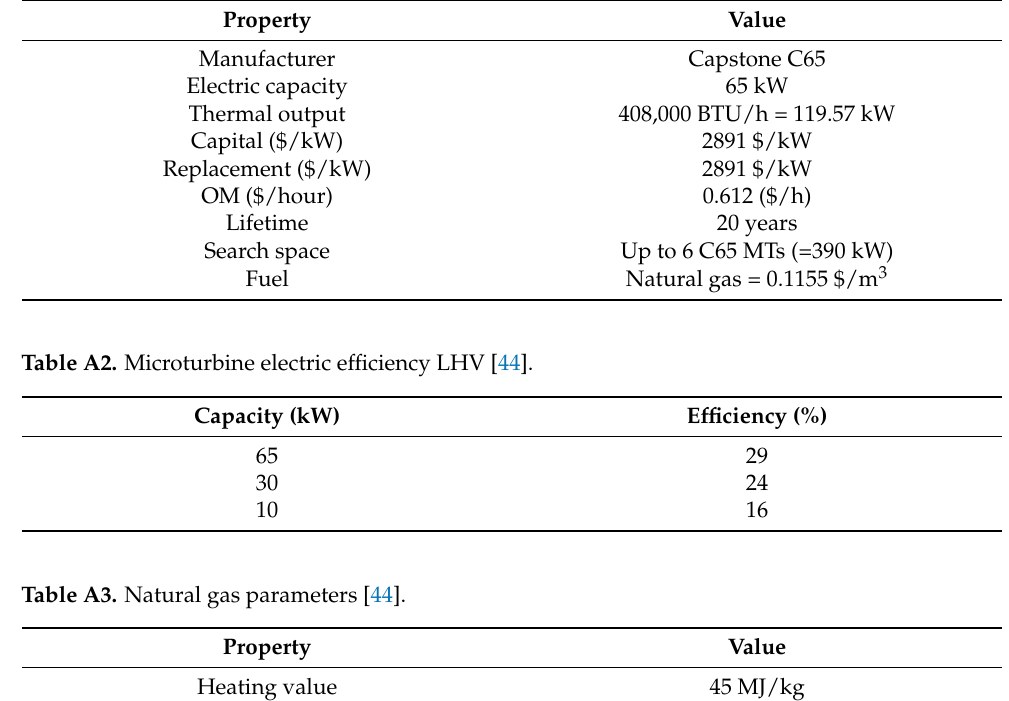
Table A1. Microturbine parameters [26,27,35,42,43].